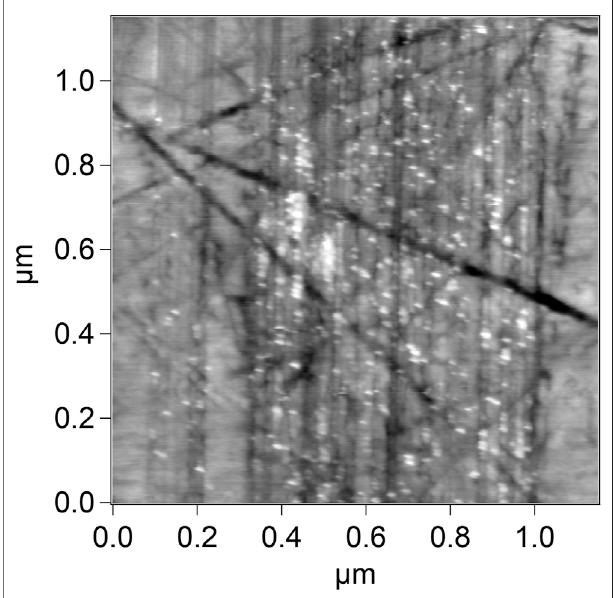
FIGURE 8 | Topography of a wear track with numerous small wear particles sticking onto the scratches. The Z -scale is ± 5